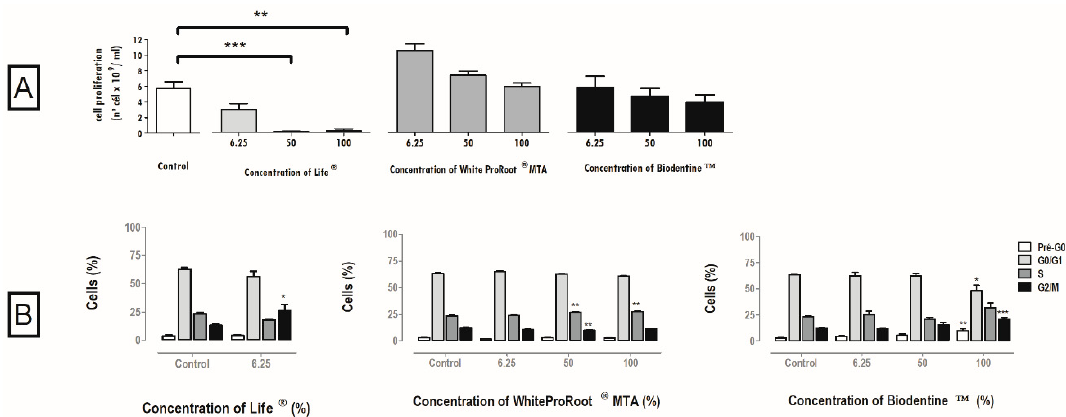
Figure 2. ( A ) Cell proliferation after 120 h of incubation with Life ® , WhiteProRoot ® MTA and Biodentine ™ conditioned media. All the results express the mean and standard error of at least seven independent assays. ( B ) Cell cycle in MDPC-23 cells treated with Life ® , WhiteProRoot ® MTA and Biodentine ™ conditioned media after 120 h of exposure. The results are represented as percentage of cells in the pre-G0, G0/G1, S and G2/M phases. The results represent the mean and standard error of five trials. Significant differences from control or between conditions are represented by *, where * means p < 0.05, ** means p < 0.01 and *** means p < 0.001.